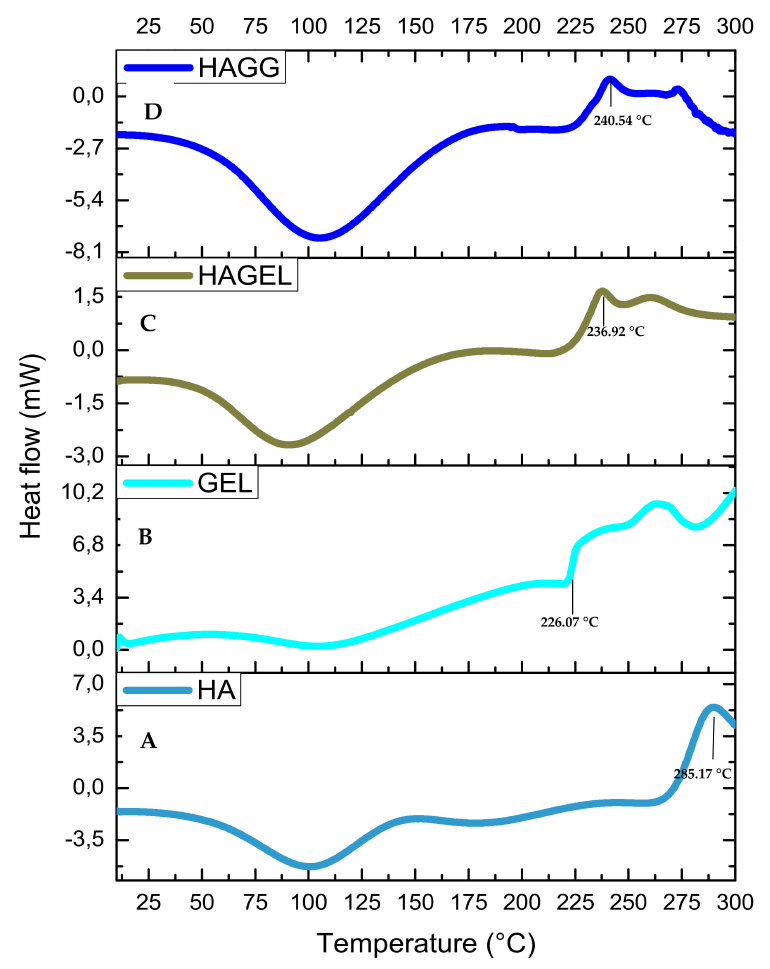
Figure 8. DSC thermogram of ( A ) HA, ( B ) GEL, ( C ) HAGEL and ( D )